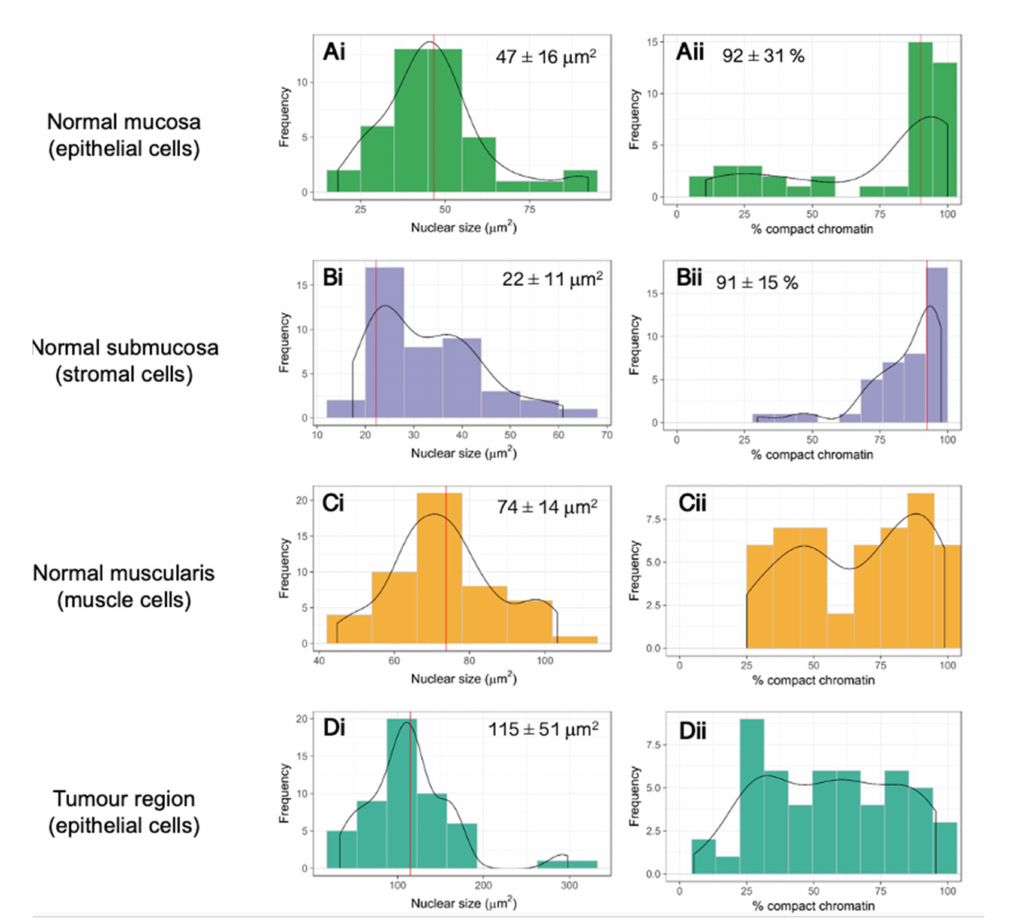
Figure 2. ( Ai – Ci ) Nuclear size distribution of normal colorectal tissue cell types: epithelial cells of the normal mucosa ( Ai ), stromal cells (Tunica submucosa) ( Bi ) and muscle cells (Tunica muscularis) ( Ci ). Nuclear size distribution of epithelial nuclei from a tumour area within a representative example of a colorectal carcinoma tissue specimen ( Di ). ( Aii – Dii ) Percentage of compact chromatin in the same normal and carcinoma colorectal cell types. Solid red vertical lines correspond to the mode from the data. Reported values are the mode ± SD. For normal distributions, the mode coincides with the mean of the distribution. Distributions in ( Cii , Dii ) might correspond to a multimodal distribution ( n =